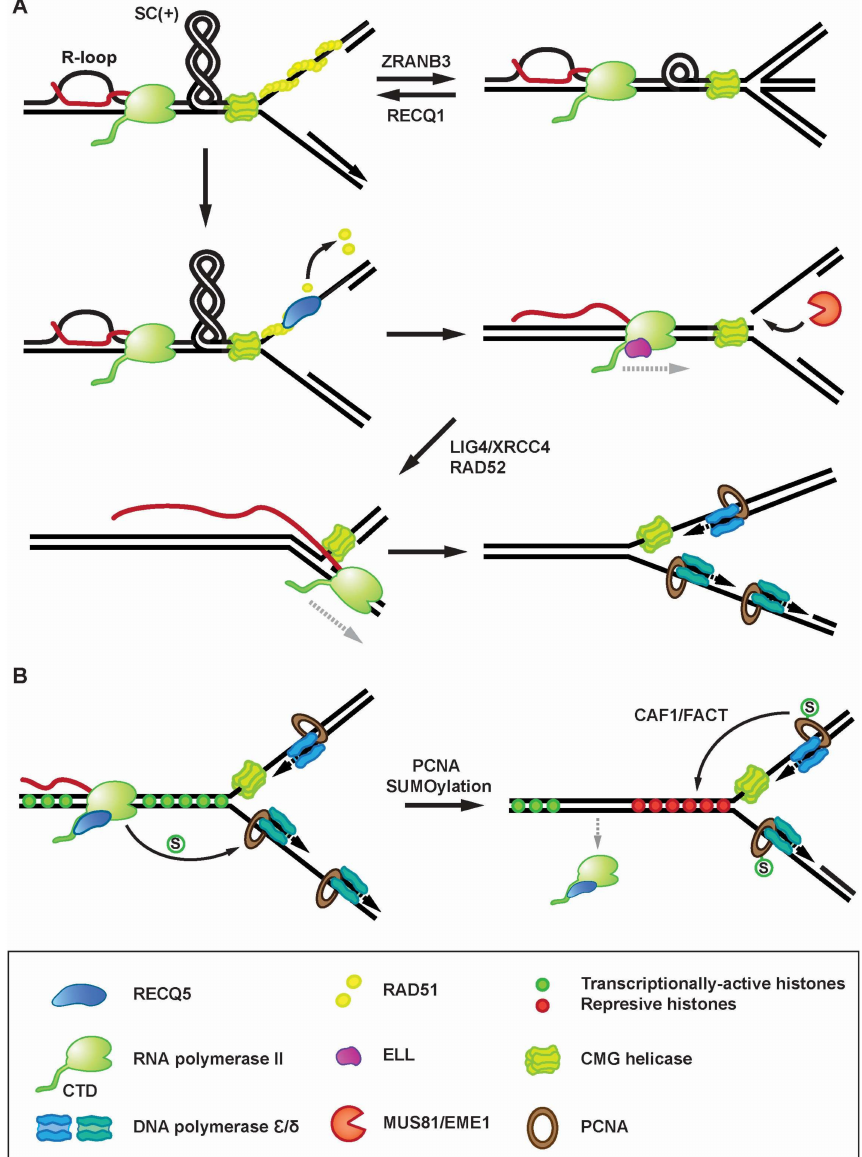
Figure 3. Proposed roles for RECQ5 in resolution of transcription-replication conflicts. ( A ) Role of RECQ5 in resolution of R-loop-mediated TRCs. Head-on TRCs can promote R-loop formation followed by the build-up of positively-supercoiled ( + SC) domains between converging transcription- and replication machineries, which will cause replication fork stalling. Stalled replication forks are protected by the RAD51 filament, which can promote fork reversal by DNA translocase ZRANB3. Fork reversal is counteracted by RECQ1 helicase. RECQ5 helicase disrupts the RAD51 filament to prevent fork reversal and to facilitate fork cleavage by MUS81 endonuclease, which releases the topological barrier in the DNA template and triggers reactivation of transcription by ELL. After fork religation by RAD52 and LIG4 / XRCC4, the reactivated transcription complex can bypass the replication-stalling site and continue RNA synthesis on the lagging arm of the fork. This is followed by replisome reloading and restart of DNA synthesis. It is assumed that after fork stalling, the replicative helicase CMG traverses the fork junction onto dsDNA via its ssDNA gate [59]. After fork religation, CMG translocates back onto ssDNA to allow the passage of the transcription complex and to nucleate a functional replisome. ( B ) TRC resolution mediated by RECQ5-dependent PCNA SUMOylation. Interaction of RNAPIIo-bound RECQ5 with PCNA triggers the PCNA SUMO2 conjugation. SUMO2-PCNA enriches histone chaperones CAF1 and FACT at replication forks to deposit repressive histones, causing RNAPII